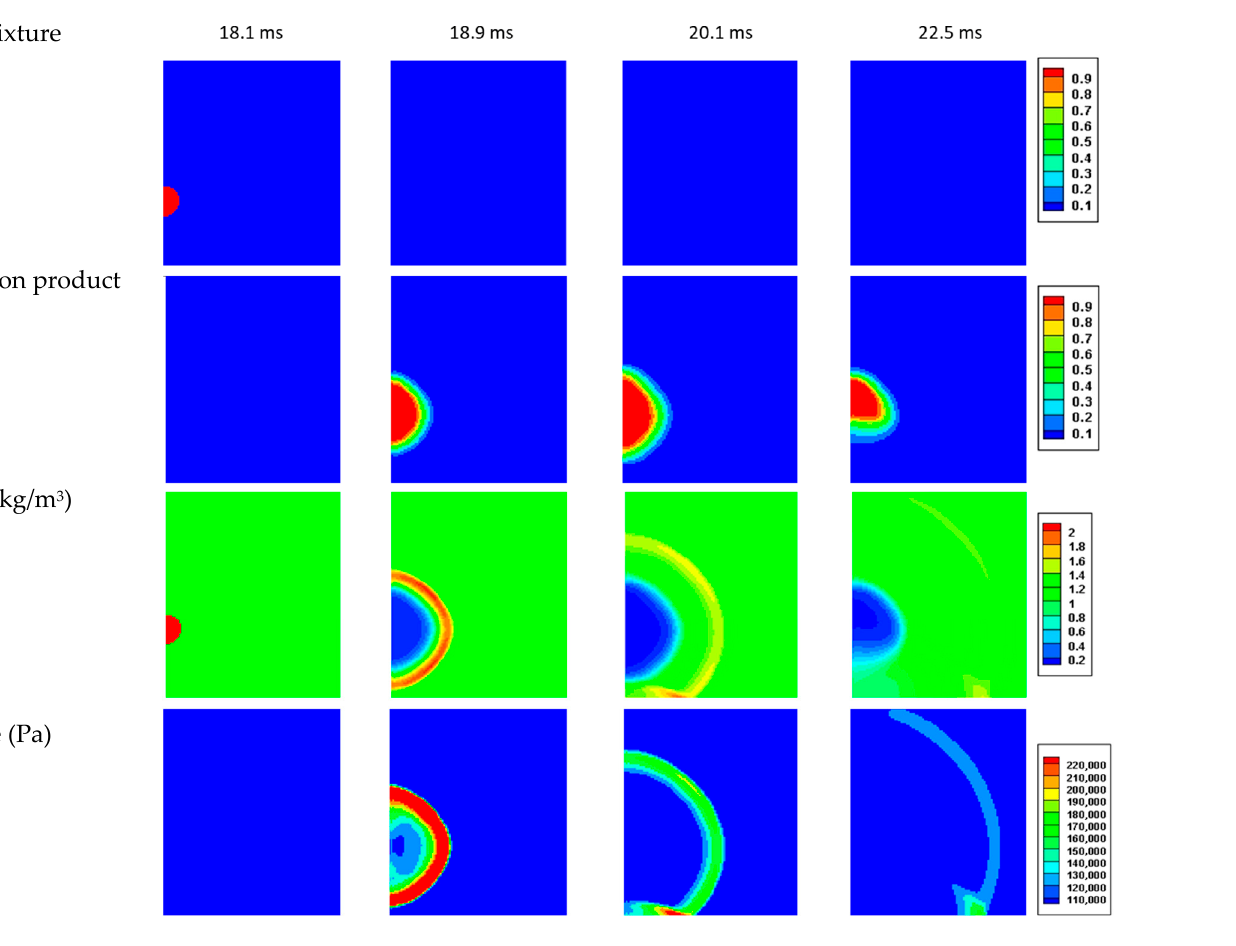
Figure 6. Sequence of images from the 100 g test simulation: ( a ) Al/air mixture concentration; ( b ) detonation product concentration; ( c ) density; and ( d ) pressure are shown at four time points.